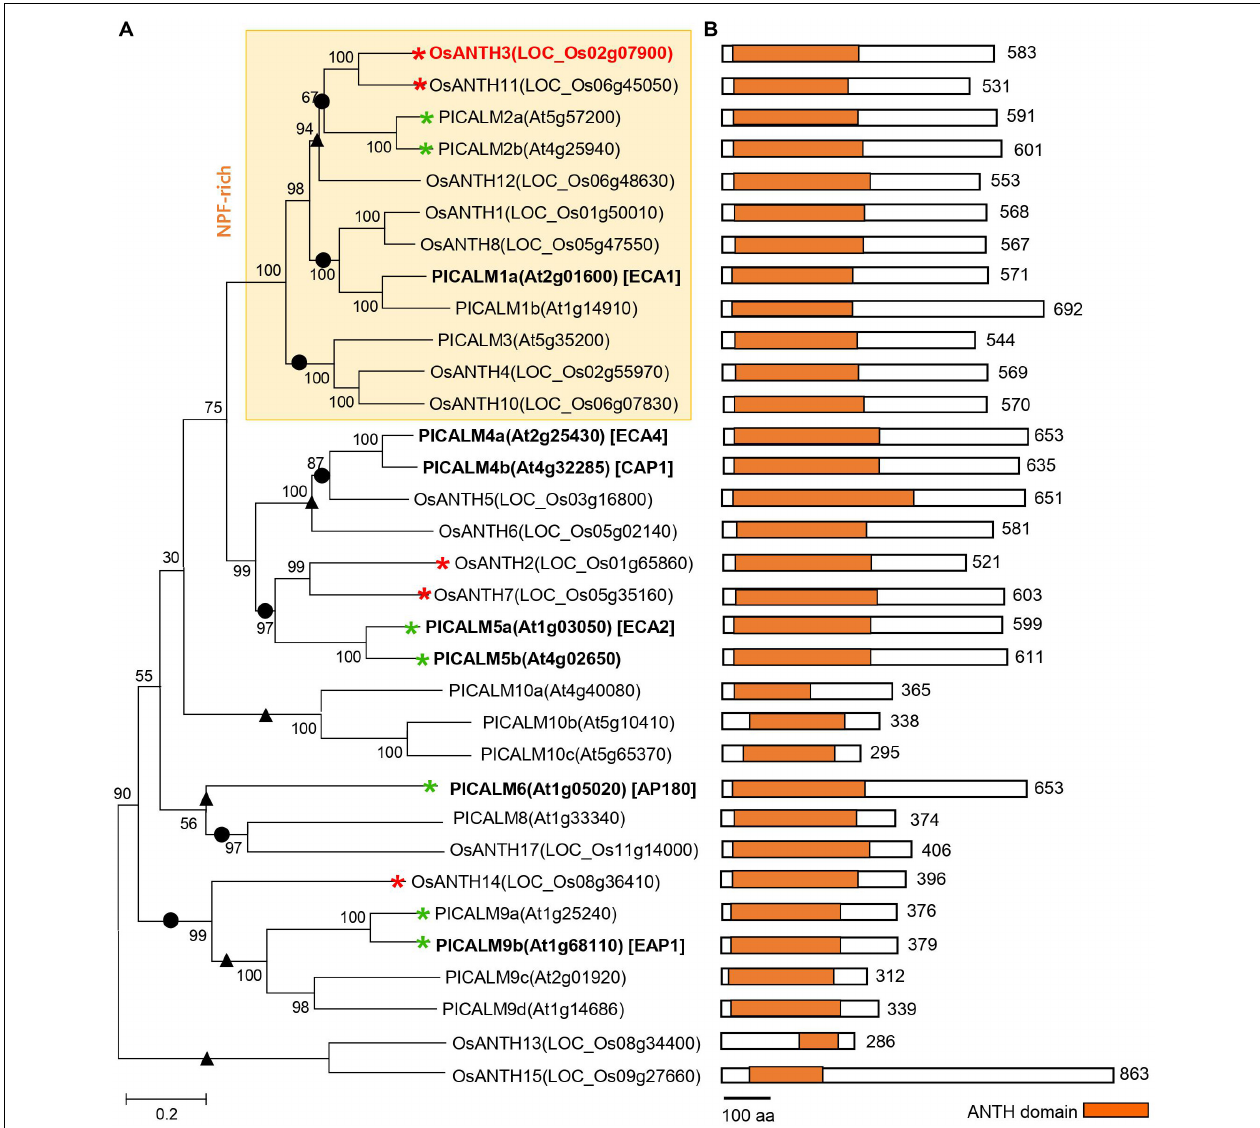
FIGURE 2 | Phylogenetic analysis of the AP180 N-terminal homology (ANTH) family from Oryza sativa and Arabidopsis thaliana . (A) Phylogenetic tree constructed using the protein sequences for each gene with MEGA7 software. Red and green asterisks indicate ANTH genes with pollen-preferential expression in rice (in this study) and Arabidopsis (Muro et al., 2018; Supplementary Figure 6 ), respectively. Bold letters indicate the functionally characterized genes, and red color indicates genes for which the mutant phenotype was analyzed in this study. We used 1,000 bootstrap replicates, and the number at each node is a bootstrap value. • and (cid:78) indicate branches conserved and diversified between Arabidopsis and rice, respectively. (B) Schematic diagram of the ANTH protein primary structure with the ANTH domain. The length of each ANTH protein is shown on the right regarding the number of amino acids (aa). The scale bar indicates 100 aa. Orange boxes indicate the position and length of the conserved ANTH domain in the family. Each domain is presented in the N-terminal of the protein. OsANTH9 and OsANTH16 are not aligned because the gene length is too